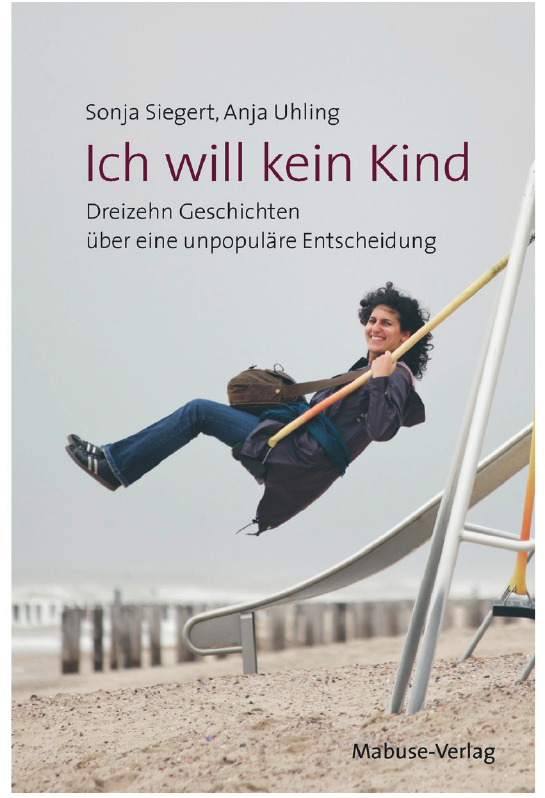
Figure 28 Childless – So What? (2006). Used by kind permission of